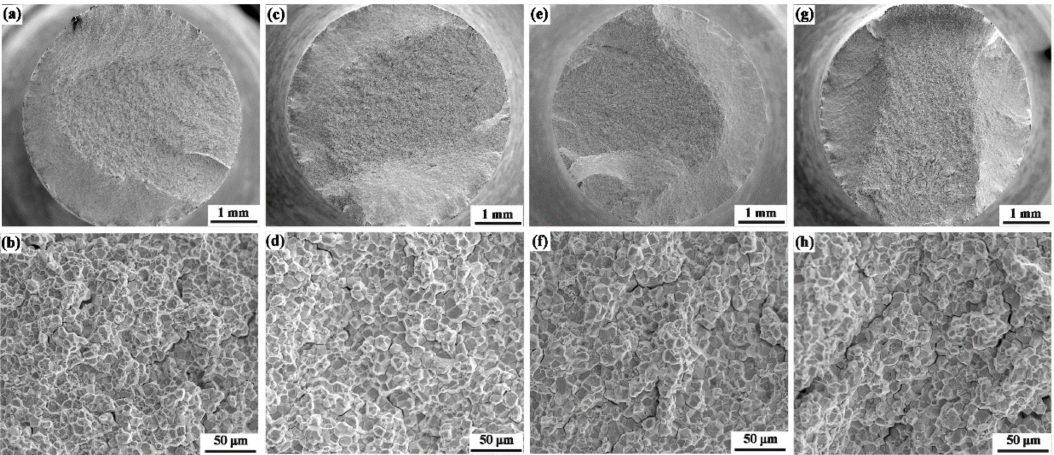
Figure 7. SEM images of the stress rupture fracture surface: ( a , b ) alloy 1, ( c , d ) alloy 2, ( e , f ) alloy 3, and ( g , h ) alloy 4. ( b , d , f , h ) show the enlarged views of the intergranular fracture area in corresponding alloys.